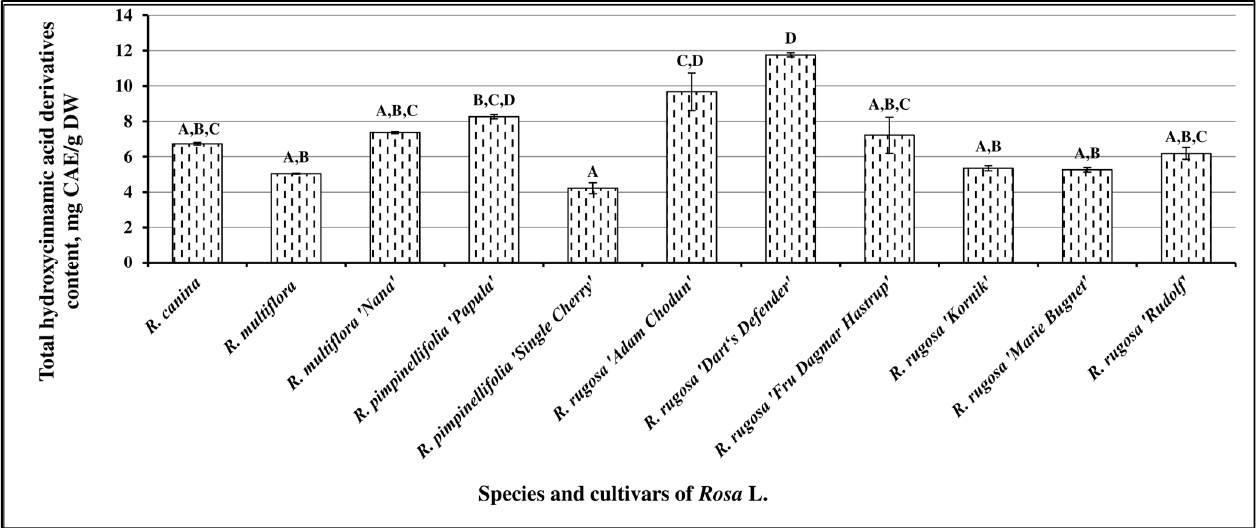
Figure 2. Variability of the total content of hydroxycinnamic acid derivatives in Rosa L. fruit samples; different letters indicate statistically significant ( p < 0.05) differences between the samples.